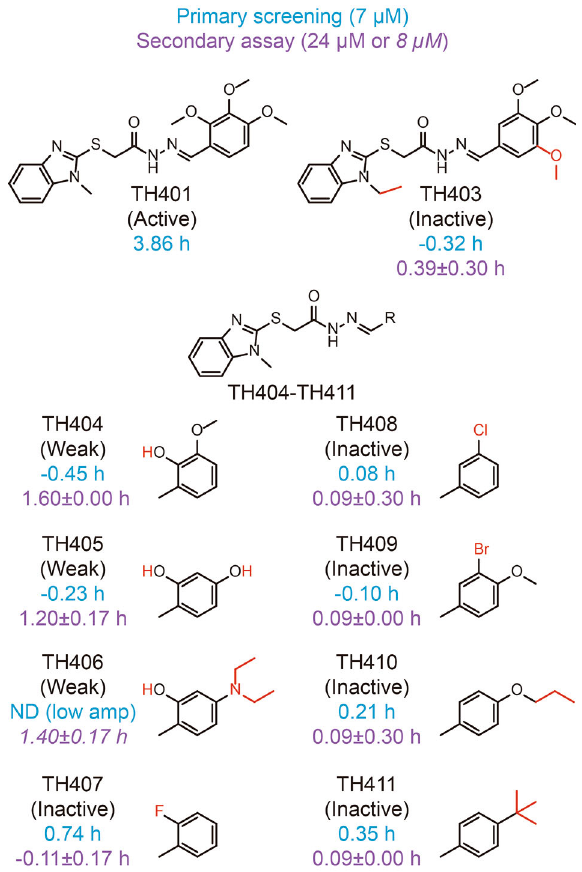
Figure4.Period-lengtheningactivities ofTH401 derivatives. Changesin thecircadianperiodof Bmal1-dLuc U2OS cells compared to a dimethyl sulfoxide (DMSO) control in primary screening (tested at 7 μ M; n = 1) and a secondary assay(testedat24 μ M;mean (cid:3) SD, n =3biologicallyindependentsamples)areshowninblueandpurple,respectively, with chemical structures. TH406 caused low amplitude with unreliable period estimation (ND, not determined) in primary screening and the secondary assay at 24 μ M, and were therefore tested at 8 μ M (shown in italics). Modified part of the compound is shown in